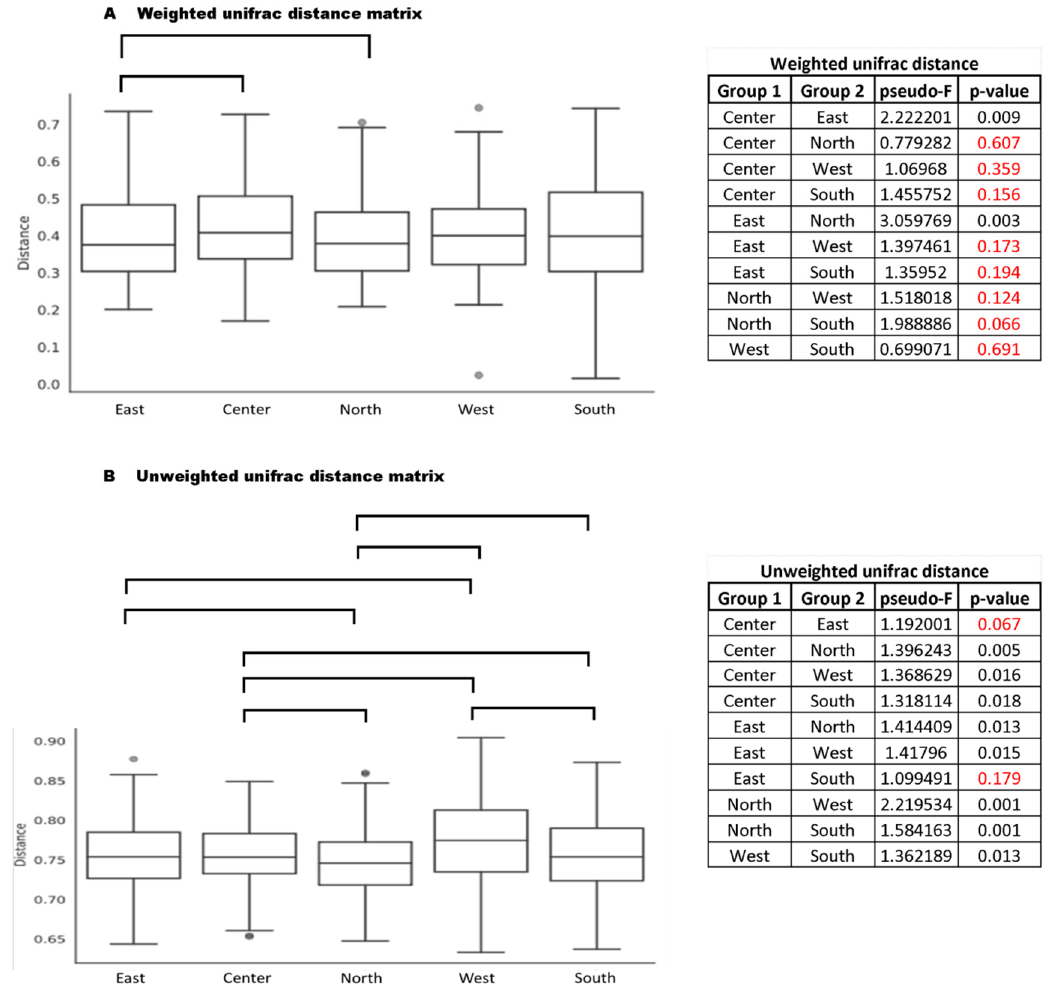
Figure 7. Pairwise permanova results of different regions. A. Weighted unifrac distance matrix B. Weighted unifrac distance matrix. Results highlighted in red indicate p values greater than 0.05. Bars represent the pairs of regions with significant differences.